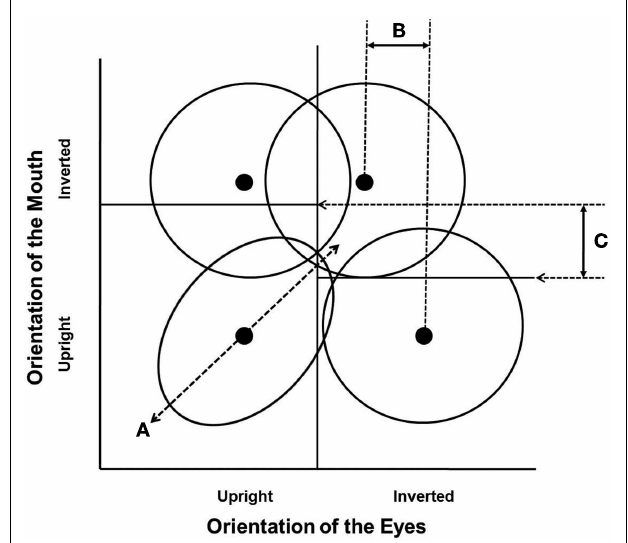
FIGURE 1 | Schematic representation of three ways of theoretically representing configurality in GRT. (A) illustrates the correlation within the perceptual information predicted by a violation of perceptual independence; (B) illustrates the differences in the marginal means for the orientation of the eyes predicted by a violation of perceptual separability; (C) illustrates the differences in the location of the decision bounds for the orientation of the mouth as a function of the level of the eyes predicted by a violation of decisional